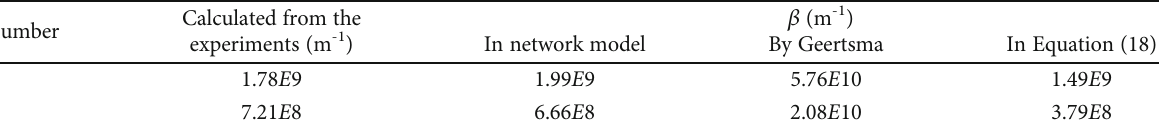
Table 3: Comparison of the β by the di ff erent method.